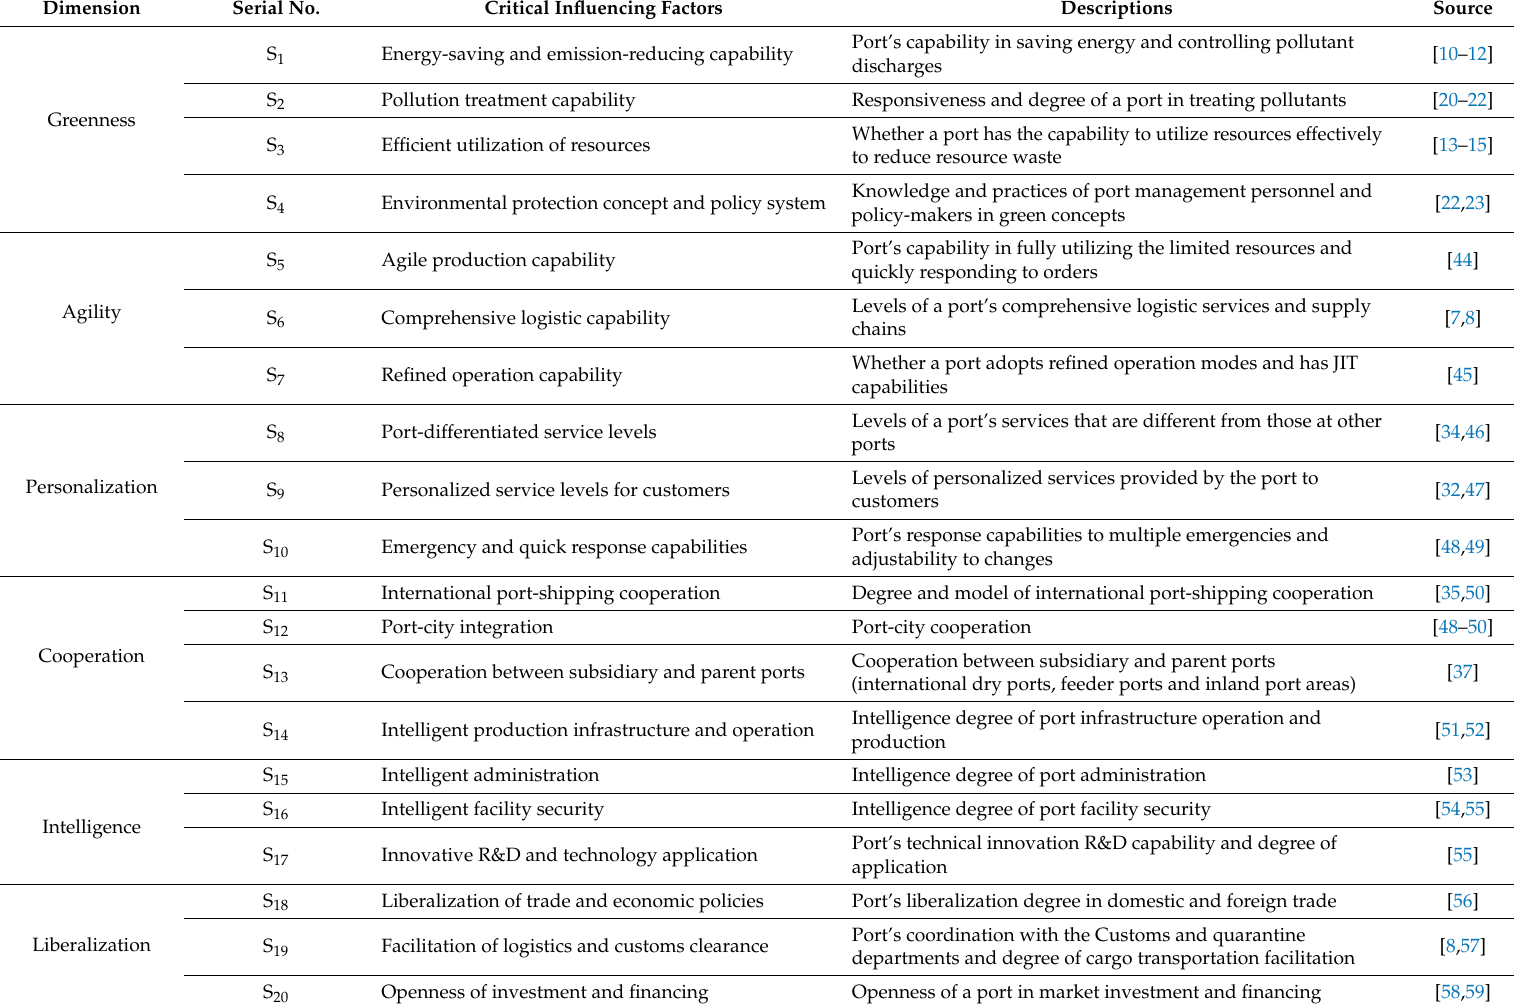
Table 2. Description of critical influencing